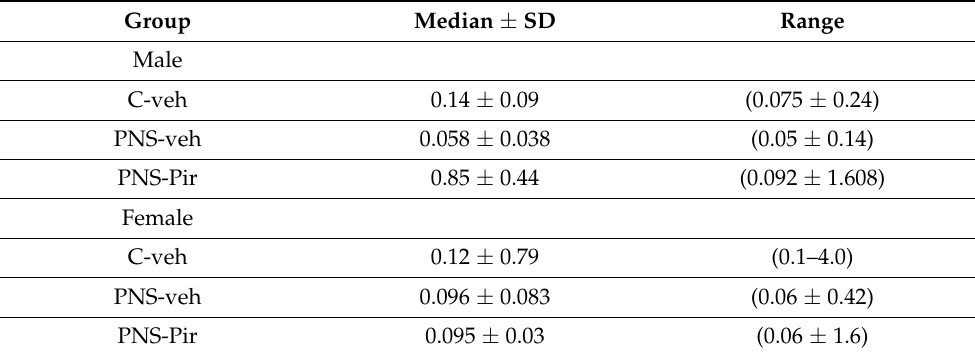
Table 1. The chronic Piromelatine treatment tended to increase melatonin levels in PNS male rats but did not affect the hormonal level in plasma of female rats with PNS ( p >